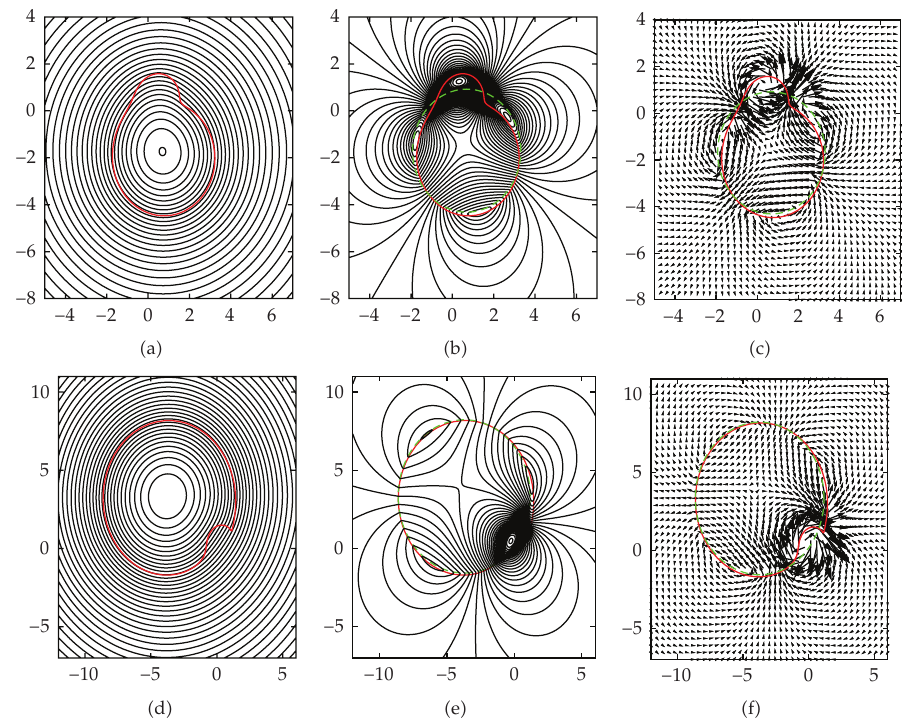
Figure 9: As in Figure 7, but for the vortices in Figures 5 (cid:2) c (cid:3) and 5 (cid:2) f (cid:3) . The jumps between two consecutive streamlines are (cid:2) a (cid:3) 0 . 2, (cid:2) b (cid:3) 0 . 01, (cid:2) d (cid:3) 0 . 5, and (cid:2) e (cid:3) 0 . 02. The scale factors in drawing the di ff erential velocities are (cid:2) c (cid:3) 5 and (cid:2) f (cid:3)